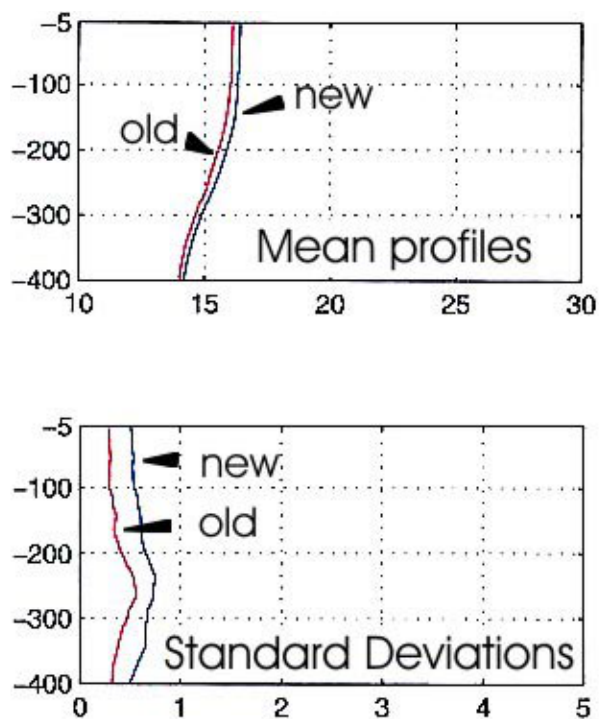
Fig. 5. Mean profiles and standard deviations obtained using the MedAtlas data only (old) and adding the MFSPP-VOS data (new). The example is provided for the month of March in area 19. This is one particular area where MFSPP-VOS added a very significant amount of